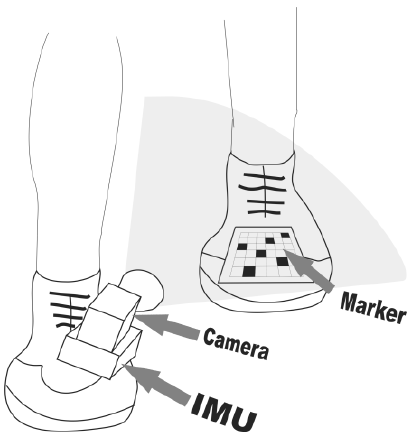
Figure 1. Our proof-of-concept